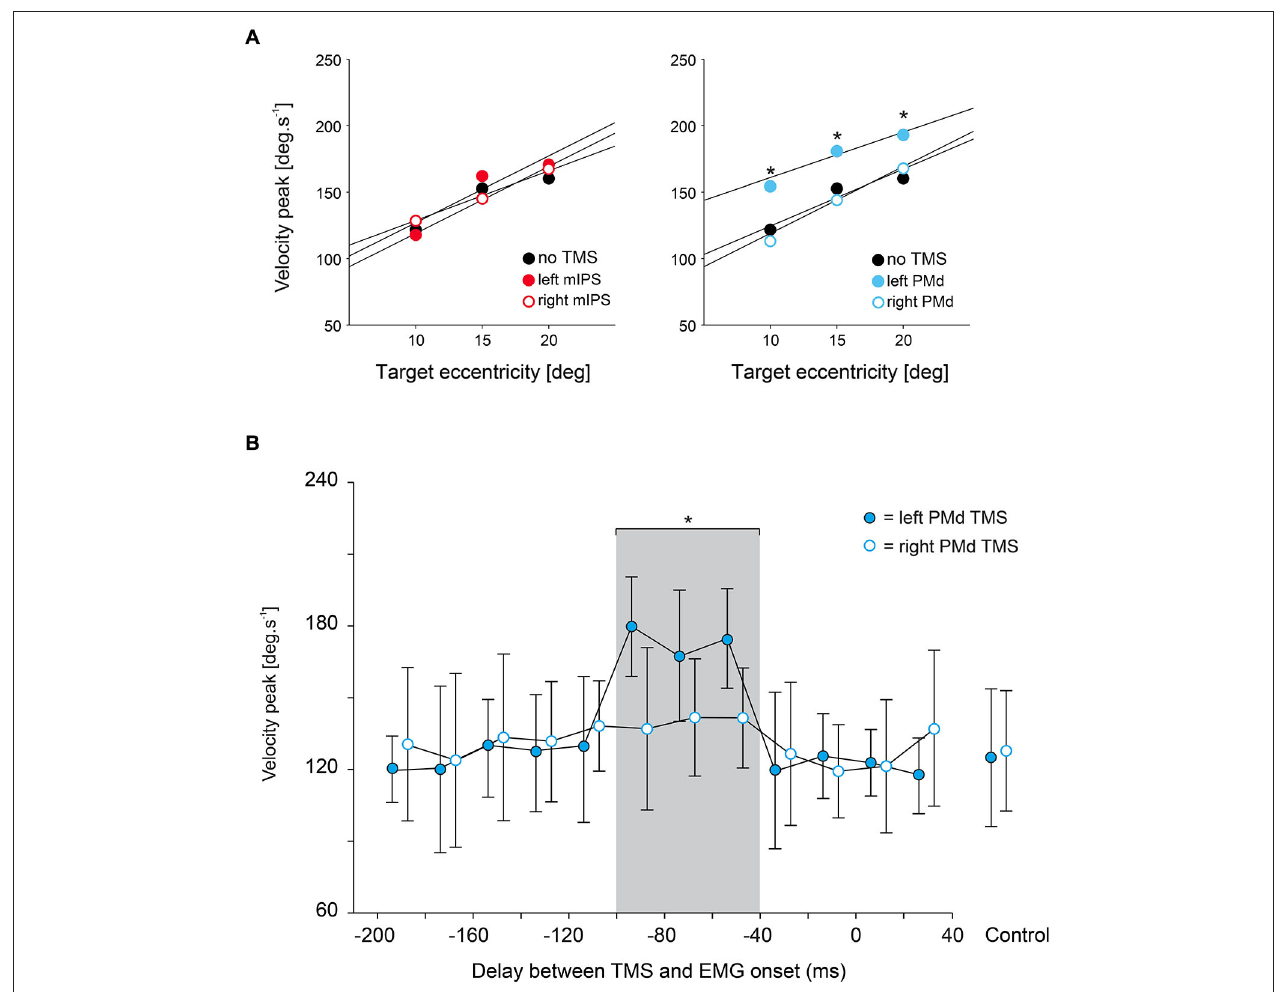
shown). (B) Time course of the effects of left PMd virtual lesions. Data were assigned to bins of 20 ms width. X -axis: delay between TMS triggering and movement onset. Y -axis: peak velocity. TMS over left PMd increased velocity peak only when applied in 100–40 ms before movement onset; the gray shading area highlights data points significantly different from control (no TMS) condition. Error bars illustrate ± 1 SD. TMS applied over right PMd had not affect on velocity peaks of movements performed with the right